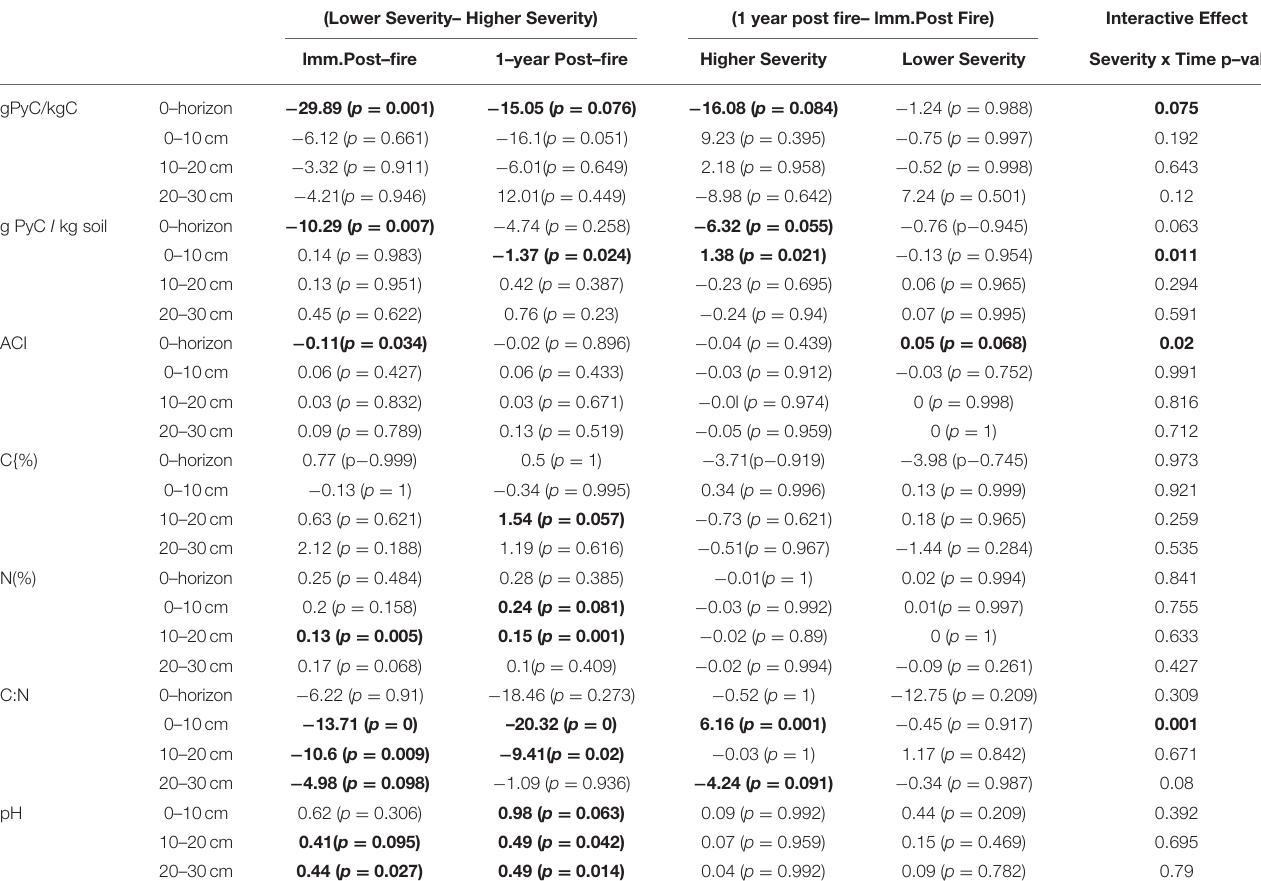
TABLE 2 | Differences in mean response variables at different time points for grab samples collected at the distributed plots from both immediately post-fire and 1-year post-fire from soil plots that burned at lower and higher severity during the Chimney Tops 2